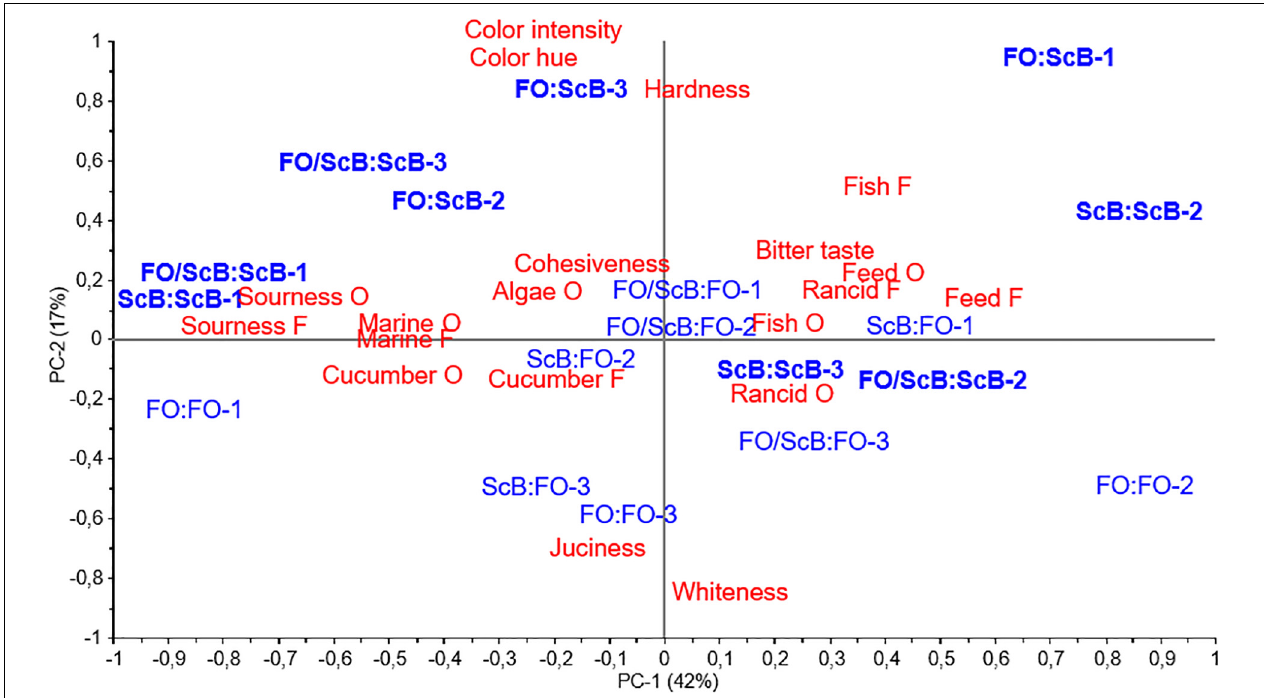
FIGURE 3 | Sensory analysis. Effect of pre-feeding on cage level – 4.15 kg mean body weight Atlantic salmon. Principal component analysis biplot (scores and loadings) and the effect of pre-diet (FO, FO/ScB, or AcB) and end diet (FO or ScB) on Atlantic salmon filet flavors (F) and odors